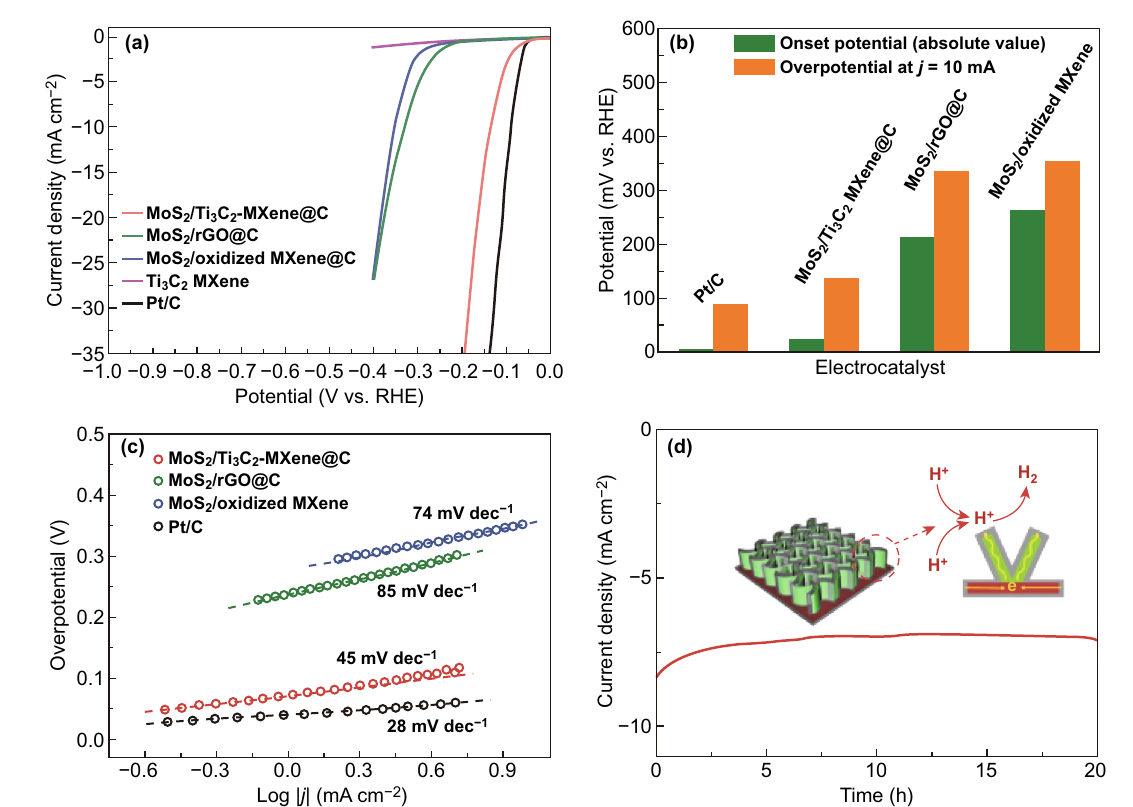
Fig. 7 a Polarization curves of MoS 2 /Ti 3 C 2 -MXene@C, MoS 2 /rGO@C, MoS 2 /oxidized MXene, Ti 3 C 2 MXene, and Pt/C in 0.5 M H 2 SO 4 , b onset potential and overpotential, and c Tafel plots of MoS 2 /Ti 3 C 2 -MXene@C, MoS 2 /rGO@C, MoS 2 /oxidized MXene, and Pt/C, d time-depend- ent current density curves with overpotential of 130 mV for MoS 2 /Ti 3 C 2 -MXene@C. Reproduced with permission from Ref. [119]. Copyright 2017